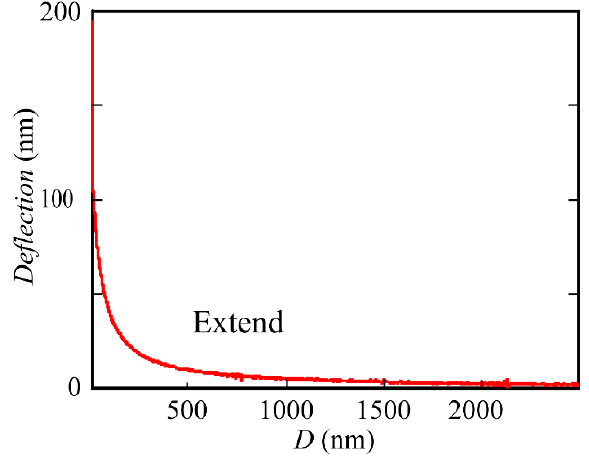
Figure 8. The extend curve transformed such that the abscissa is the separation distance.